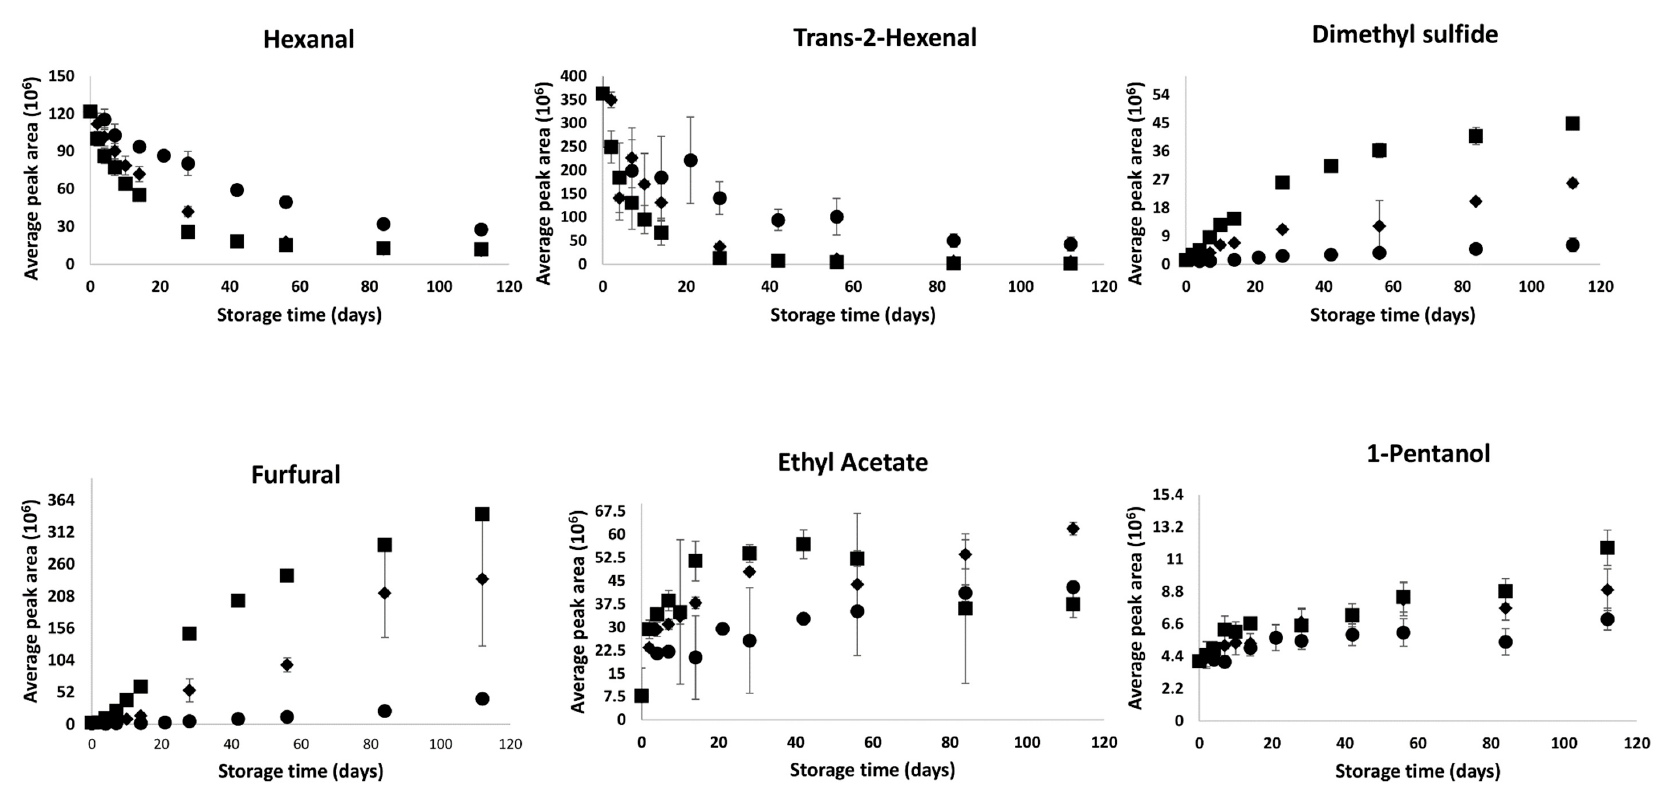
Figure 3. Average peak area of potential shelf life markers during storage in pasteurized apple juice stored at 20 ◦ C ( • ), 30 ◦ C ( (cid:7) ) and 40 ◦ C ( (cid:4) ). Standard deviation of 4 individual headspace extraction is